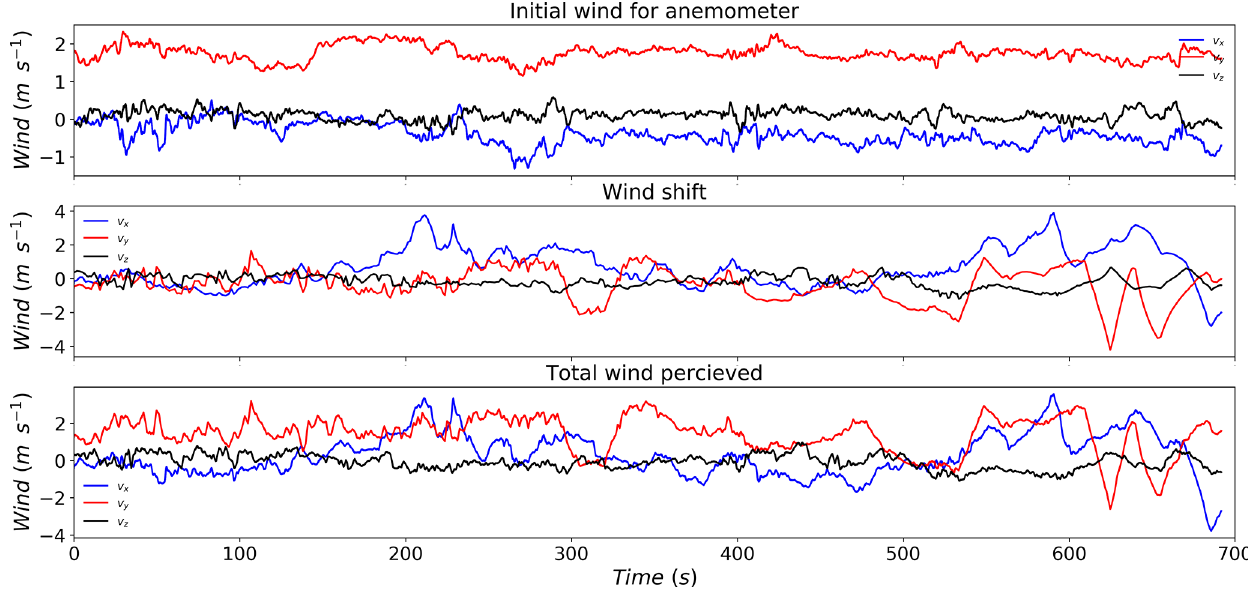
Figure 7. (Top) Temporal evolution with 0.01s time steps of the wind data from 3D sonic anemometer, (middle) the wind shift and (bot- tom) the total wind perceived by the 0.5mm drop falling from the position ( 0 , 0 , 1500 ) during the low wind event. Bottom panel is actually the wind input used to obtain the trajectory of Fig. 8.